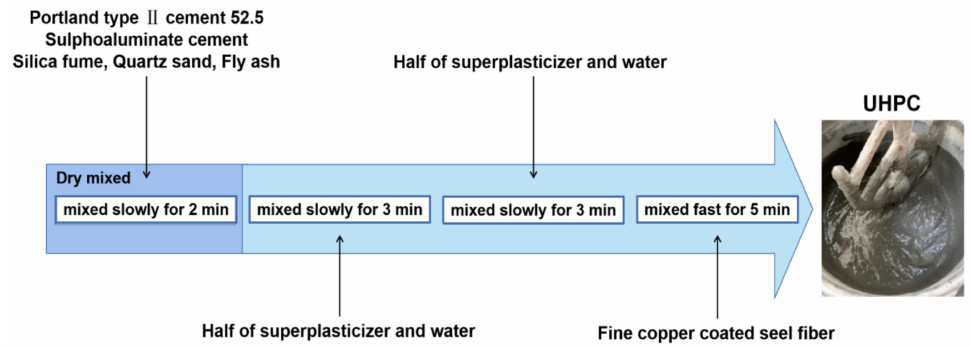
Figure 3. The preparation of UHPC.